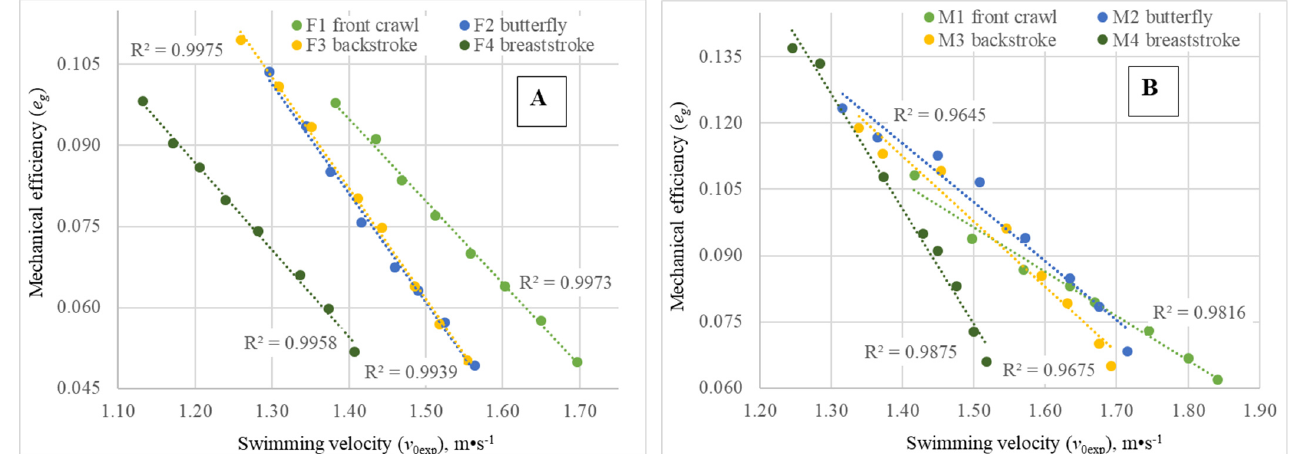
Figure 2. Functional relationships between v 0exp and P ai ( A ), and between P to and P ai ( B ) in the swimming pool 8 × 100 m step-test for male swimmers in the four swimming techniques. Legend: M1 (24 years old, height—1.89 m, body mass—